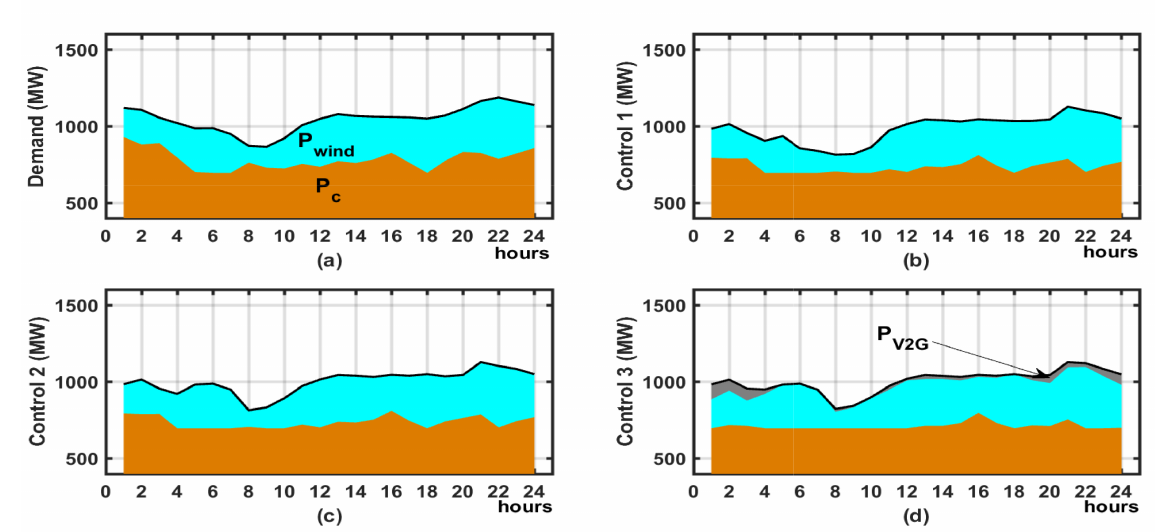
Figure 8. (Case 2) Demand and generation mix for: ( a ) w/o Control; ( b ) Control 1; ( c ) Control 2; and ( d ) Control